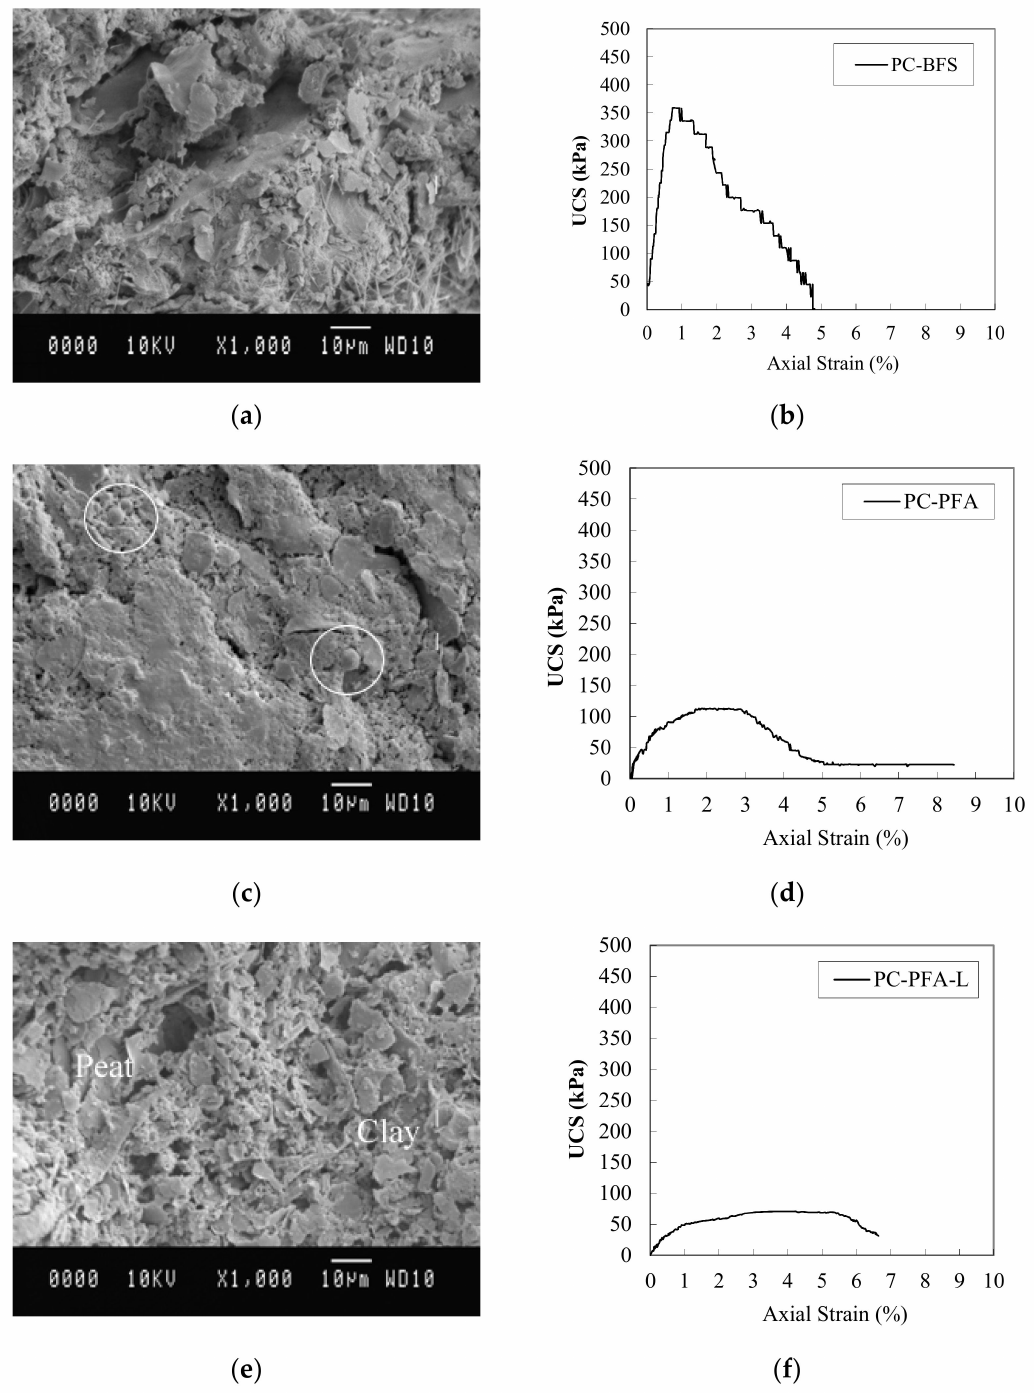
Figure 19. Stabilized OH-1 clay with 250 kg/m 3 binder amount, 28 days curing time: ( a , b ) OH-1-PC-BFS , ( c , d ) OH-1-PC-PFA and ( e , f ) OH-1-PC-PFA -